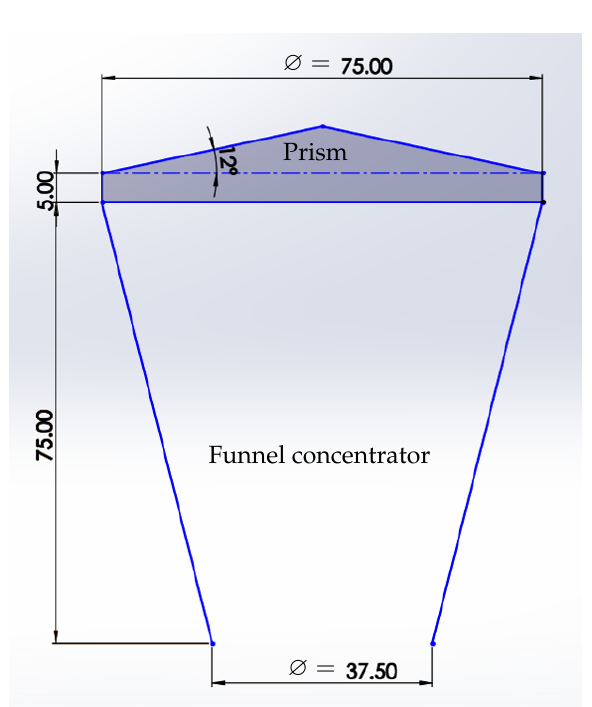
Figure 1. Cross section of the concentration system composed by the reflective Funnel and the refractive Prism.(Dimensions in mm)